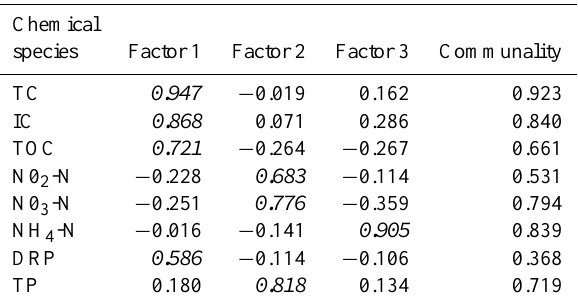
Table 4. Factor loading matrix obtained from the varimax rotation. Table 5. Factor scores used in plotting the